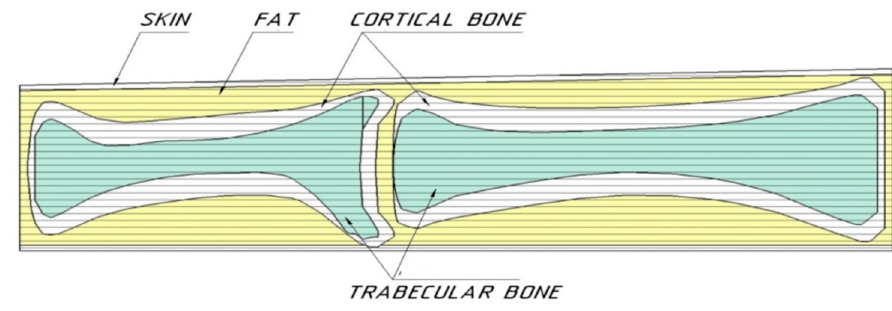
Figure 10. Cross-section of the finger model.